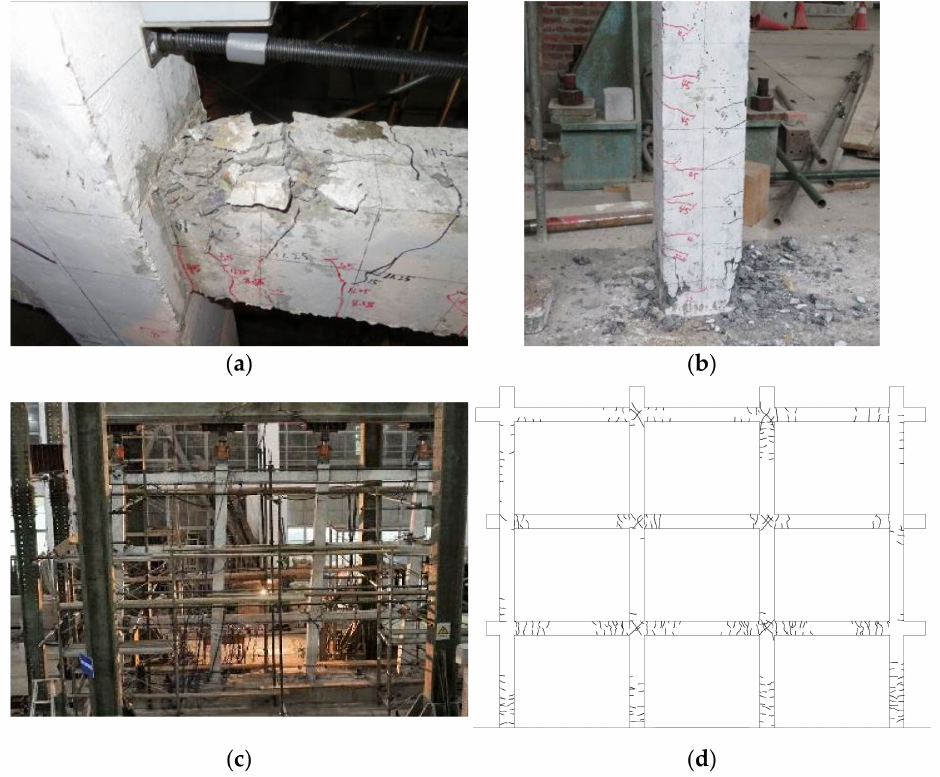
Figure 7. Damage of CF structure. ( a ) damage at second story beam end at face of column A at –H/25; ( b ) damage at base of column A at –H/25; ( c ) overall view of CF at –H/20; ( d ) final crack